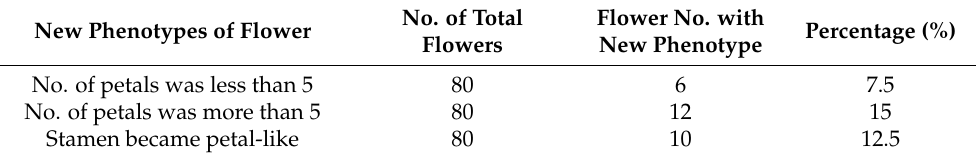
Figure 4. New phenotype of flowers observed in OfGLO1 -transformed tobacco. ( a ) Normal flower of the wild type with five sepals, five petals, five stamens, and one pistil. ( b ) A flower with four petals. ( c ) A flower with six petals. ( d ) A flower with eight petals. ( e ) A stamen that became petal-like. ( f ) Lateral view of a wild-type flower, in which the petals had been removed, showing that the pistil is shorter than the stamens. ( g ) The corolla cracked, and the sepals became petal-like (indicated with a white arrow). ( h ) The white arrow shows that one stamen became petal-like in a transgenic flower. ( i ) The white arrow shows that three stamens became petal-like in a transgenic flower. ( j ) Seeds from wild-type plants. ( k ) The transgenic plants yielded less seeds. Table 2. Three new flower types in OfGLO1 -transformed tobacco.